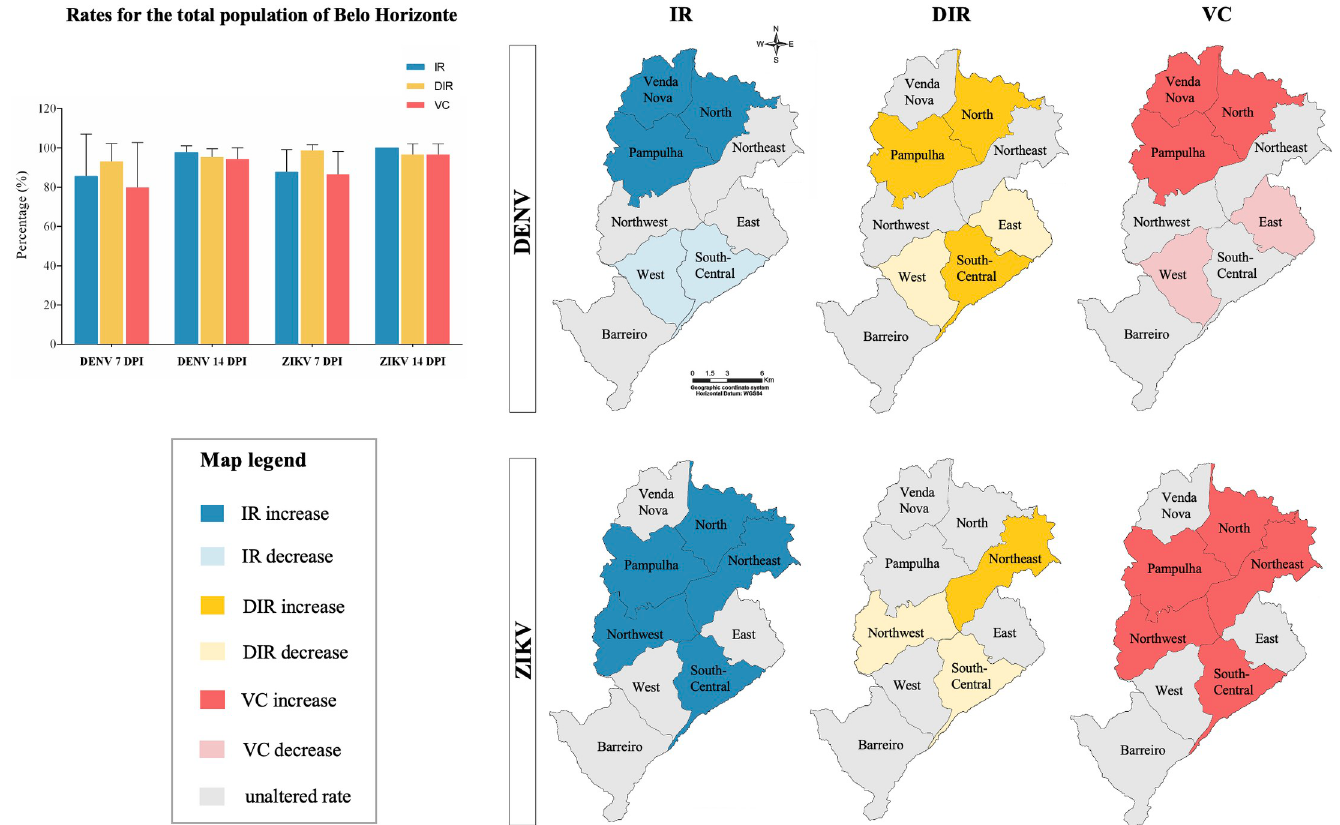
Fig 2. The graph shows the mean values of the infection rate (IR), disseminated infection rate (DIR), and vector competence (VC) for DENV and ZIKV at early infection (7 days post-infection—dpi), and late infection (14 dpi), considering the Aedes aegypti mosquitoes from all regions of Belo Horizonte. The schematic maps show the rates that increased, decreased or remained unaltered from 7 to 14 dpi. (The schematic maps were adapted from a previously published map [28], source: